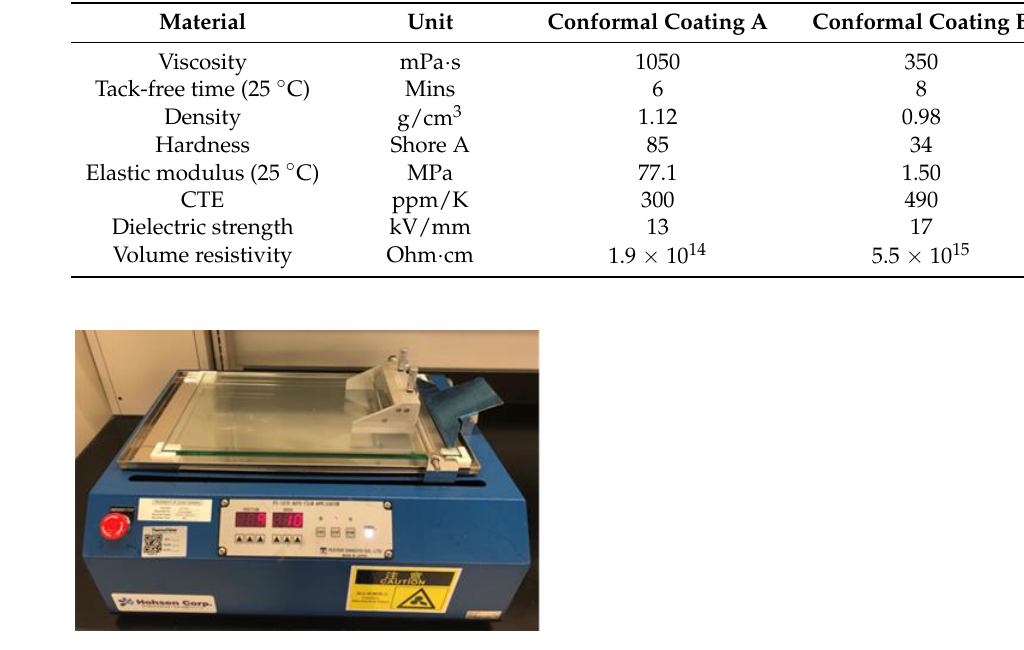
Figure 1. Prepare silicone conformal coating A and B films with an auto film applicator.